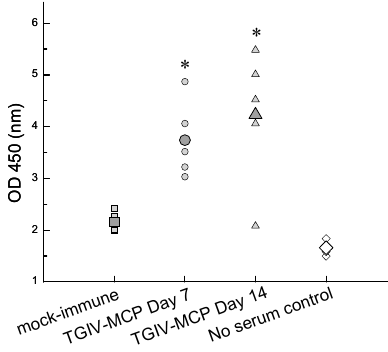
Figure 4. Induction of TGIV-MCP specific antibodies in immunized grouper. Serum samples were taken at 7 and 14 days post-immunization from 5 grouper immunized with recombinant TGIV-MCP protein. The serum samples were assayed by ELISA with anti-TGIV-MCP polyclonal antibodies. The large symbols represent average titer of the five samples in each treatment. * p < 0.05.